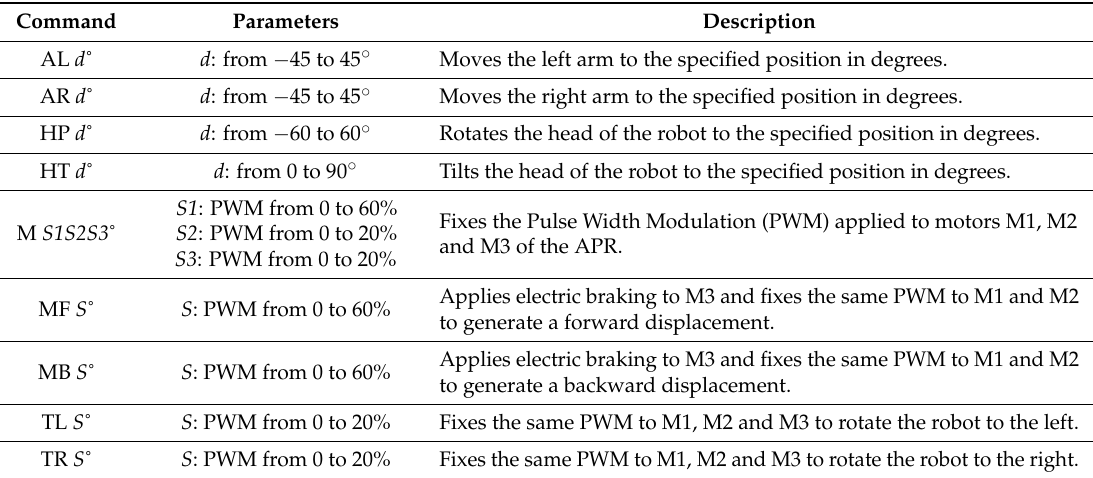
Table 4. Instruction set orders interpreted by the